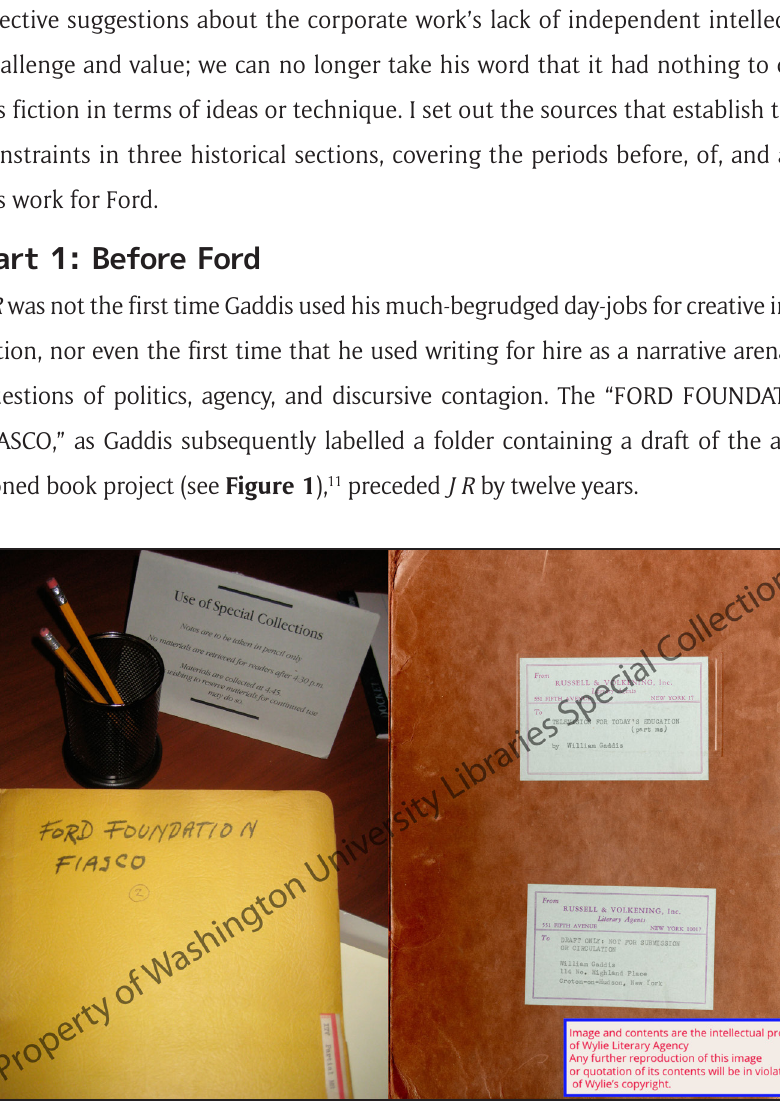
Figure 1: Folders containing draft versions of Gaddis’ completed